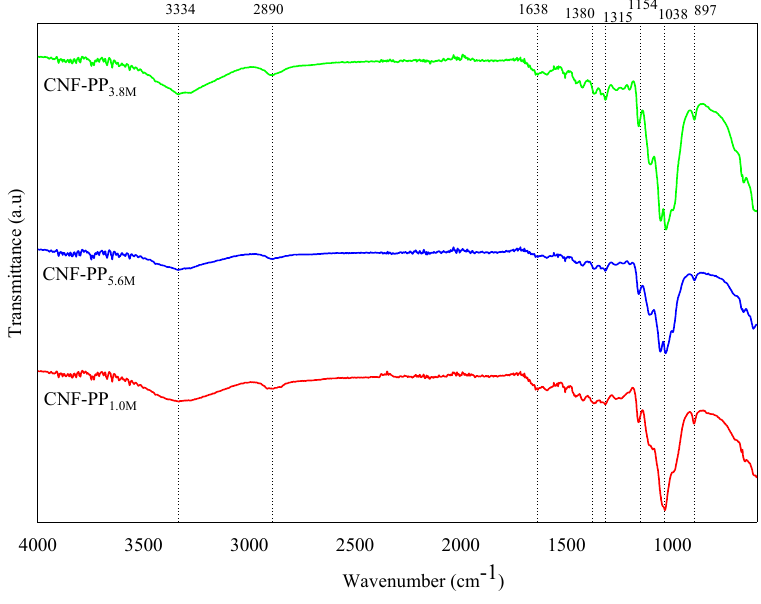
Figure 4. FTIR spectra of CNF-PP 1.0M , CNF-PP 3.8M and CNF-PP 5.6M .